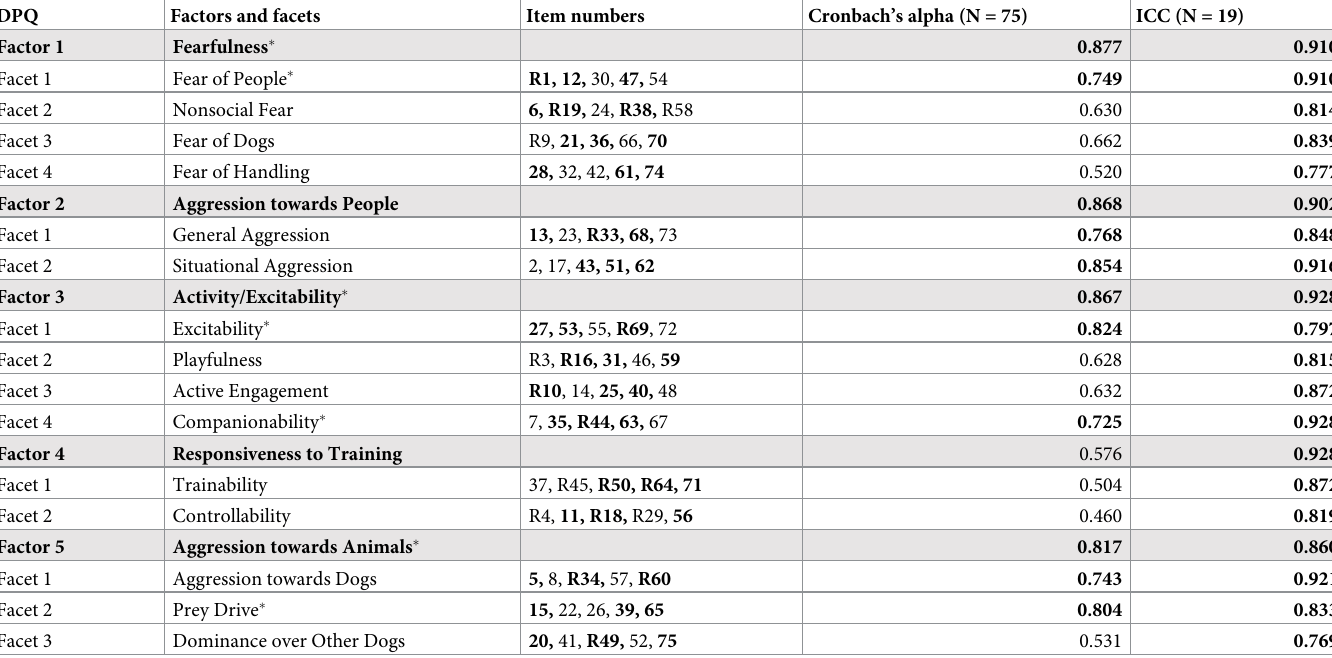
Table 2. Factors, facets, item numbers, Cronbach’s alpha and inter-rater reliability of the Dog Personality Questionnaire (DPQ).